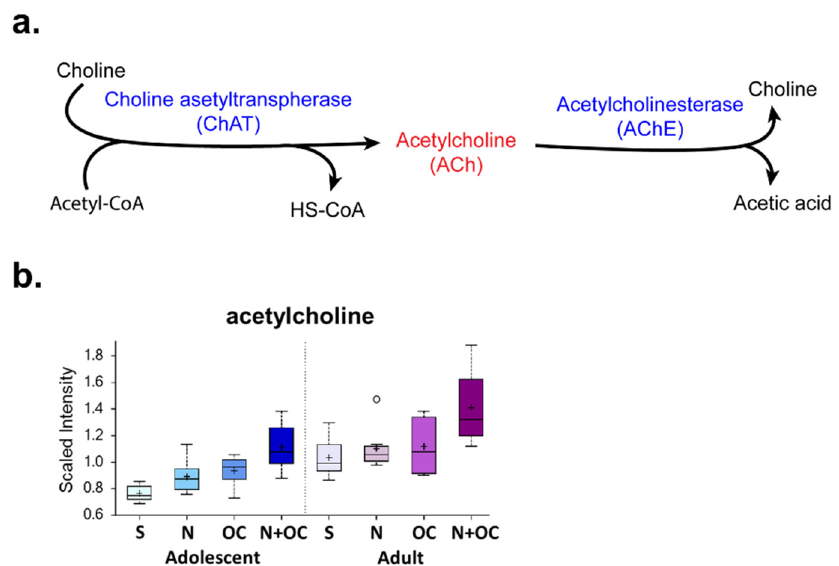
Figure 7. N + OC increases acetylcholine levels in the cortex of adolescent female rats. ( a ) Biosyn- thesis and degradation of the neurotransmitter acetylcholine. ( b ) The table shows fold change of acetylcholine; the red colored boxes represent a significant increase ( p ≤ 0.05) in that metabolite.